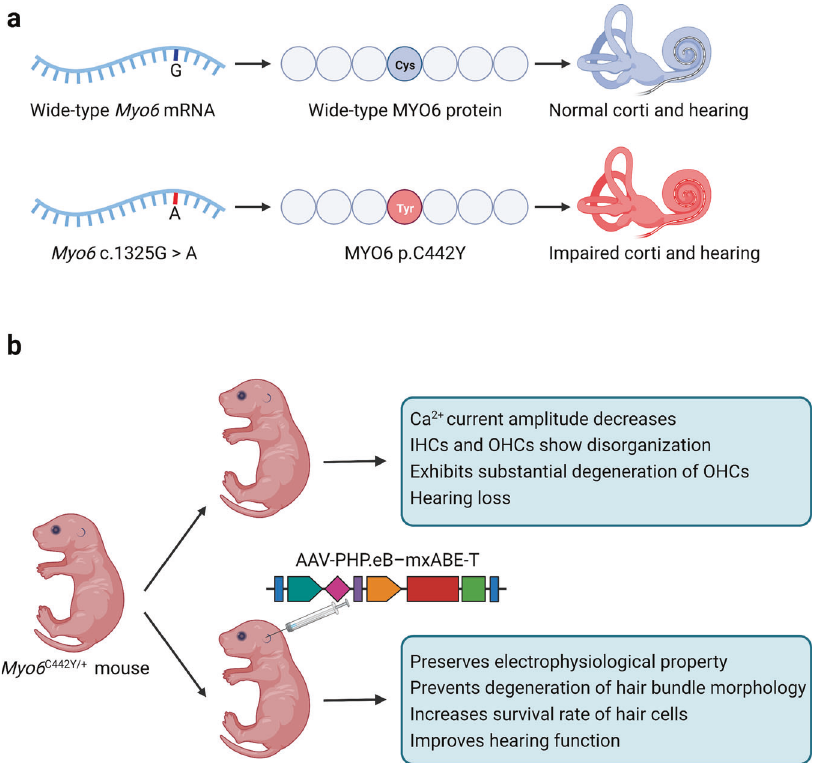
Fig. 1 Programmable base editing rescues auditory function of an autosomal dominant hearing loss disease. a A single G to A mutation at 1325 locus in the MYO6 gene causes corti and hearing impairment. b AAV-PHP.eB-mxABE-T treatment in Myo6 C442Y/ + mouse model. Xiao et al. co-packaged mxABE and gRNA into AAV-PHP.eB to correct the mutation in Myo6 C442Y/ + mice resulting in improved hearing function. This fi gure was created with